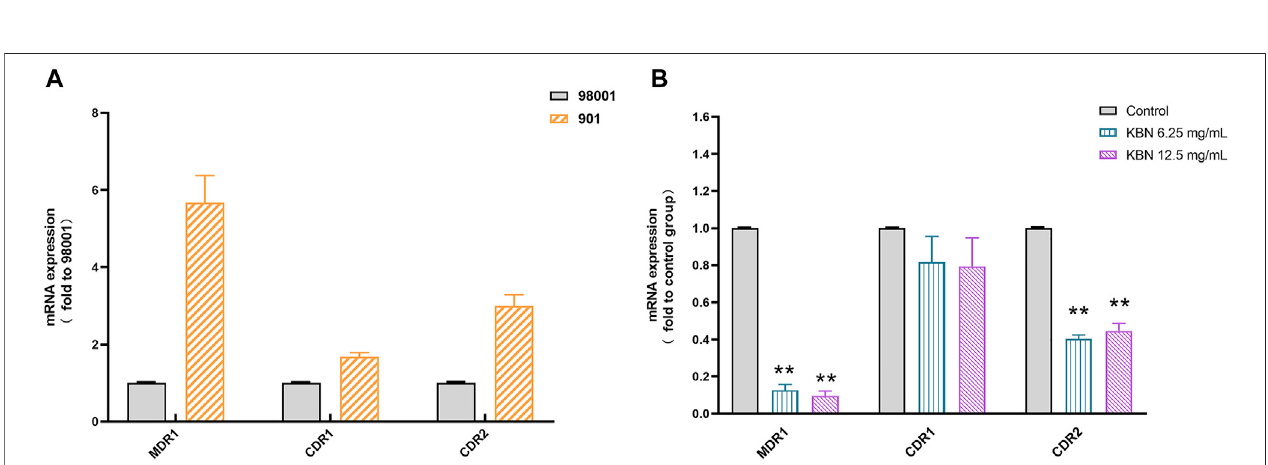
FIGURE8| Relativeexpressionoftheef fl ux-pumpgenesin C.albicans strains. (A) Theexpressionlevelsofef fl uxpumpgenes MDR1 , CDR1 ,and CDR2 insensitive C.albicans 98001andFLC-resistant C.albicans 901. (B) Theexpressionlevelsoftheef fl ux-pumpgenes MDR1 , CDR1 ,and CDR2 inFLC-resistant C.albicans 901cells that were treated with KBN relative to those in untreated cells. Values represent the mean ± SD for three independent experiments. pp p < 0.01 versus control group.